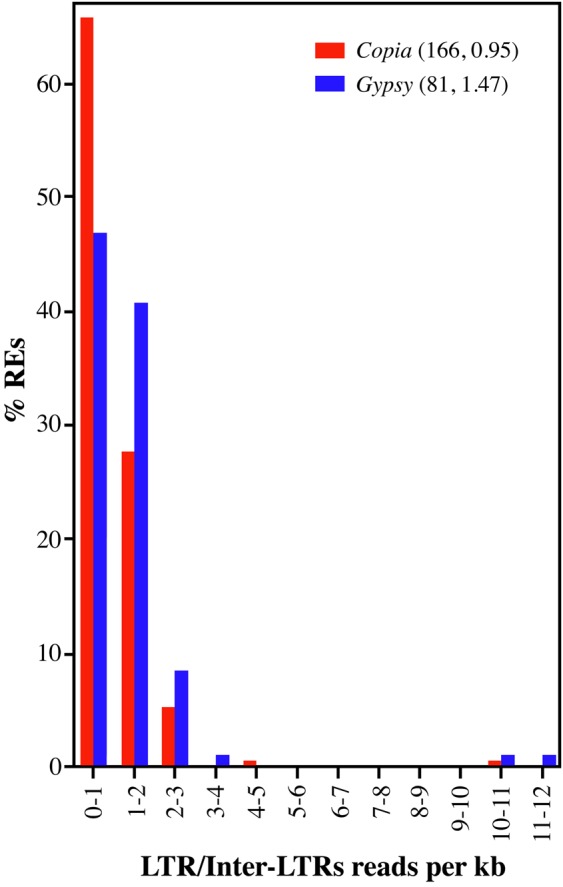
Distribution of full-length olive LTR-REs according to the ratio between the number of mapped reads per kb measured separately on LTR and inter-LTR regions.